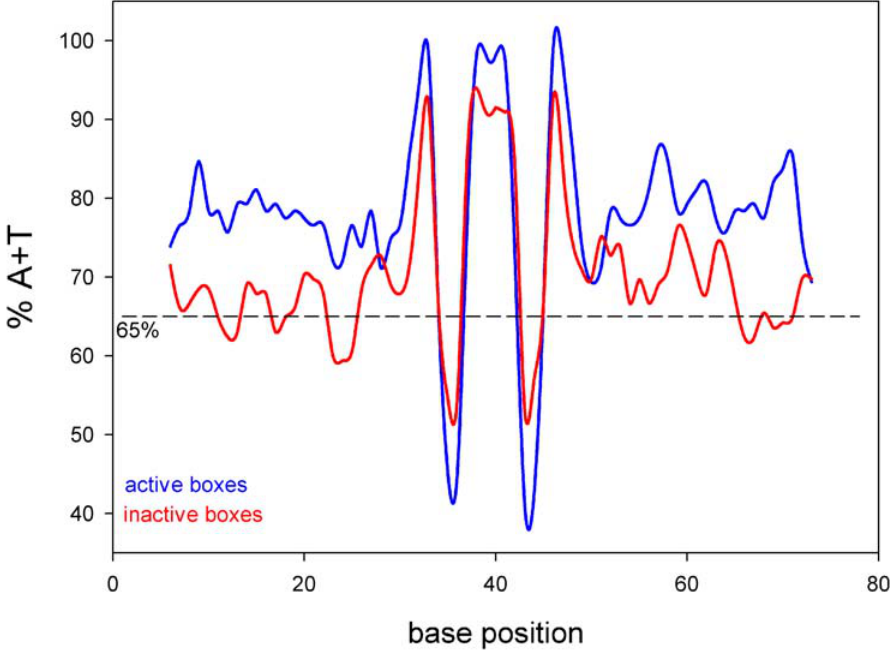
Figure 4. Percentage of A + T in the vicinity of PlcR boxes. Active boxes are plotted in blue whereas inactive boxes are plotted in red. The dashed line represents the average A + T percentage for the ATCC14579 chromosome. The difference between active and inactive boxes for the A + T percentage is highly significant (Qui-square test, p , 0.001).